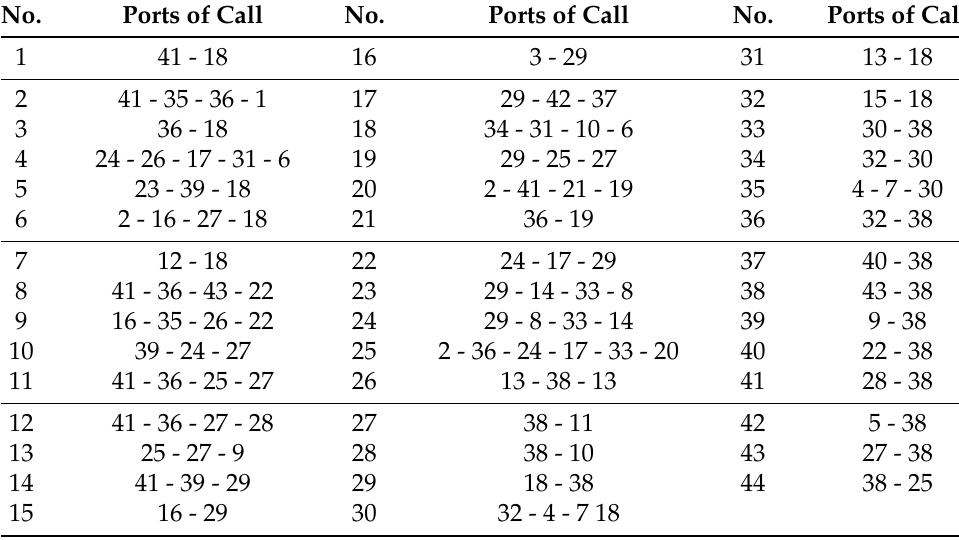
Table A2. Routes considered in this case